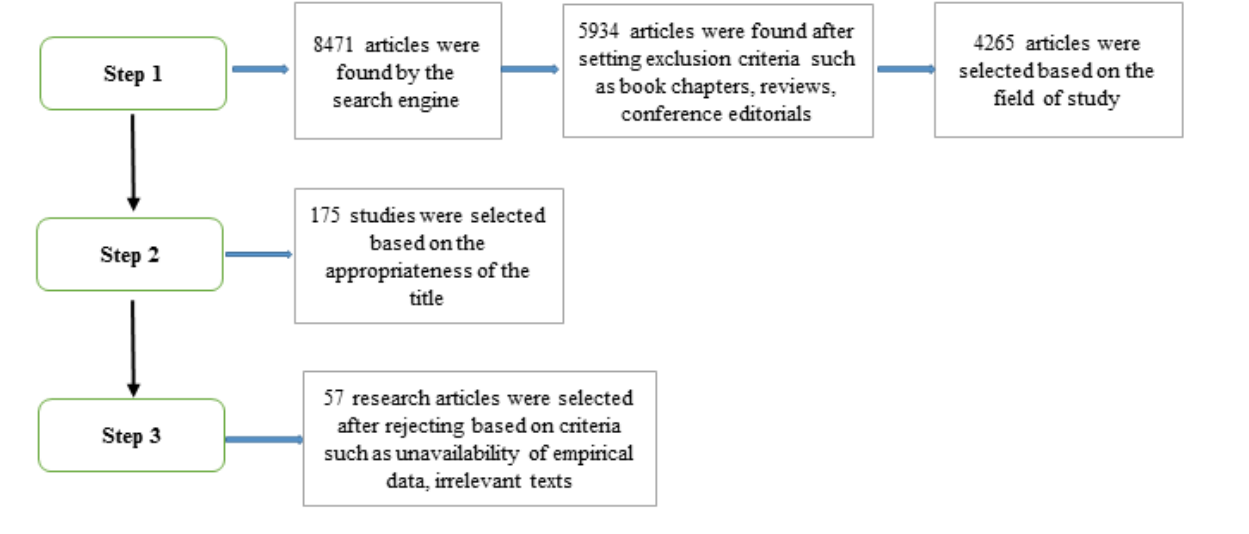
Figure 1. The article selection process for this review.